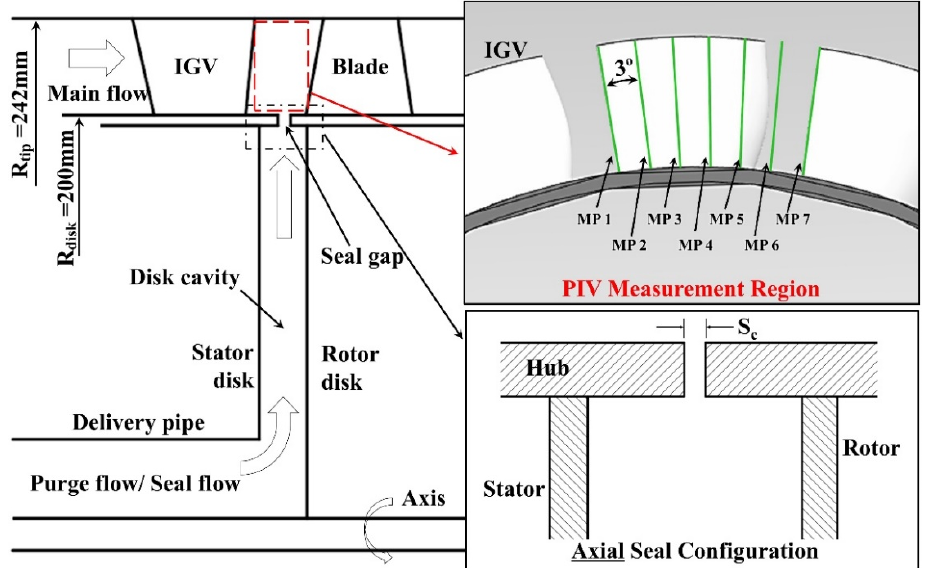
Figure 2. Structure of the research turbine with axial rim seal and PIV measurement region in annulus. IGV: inlet guide vane.